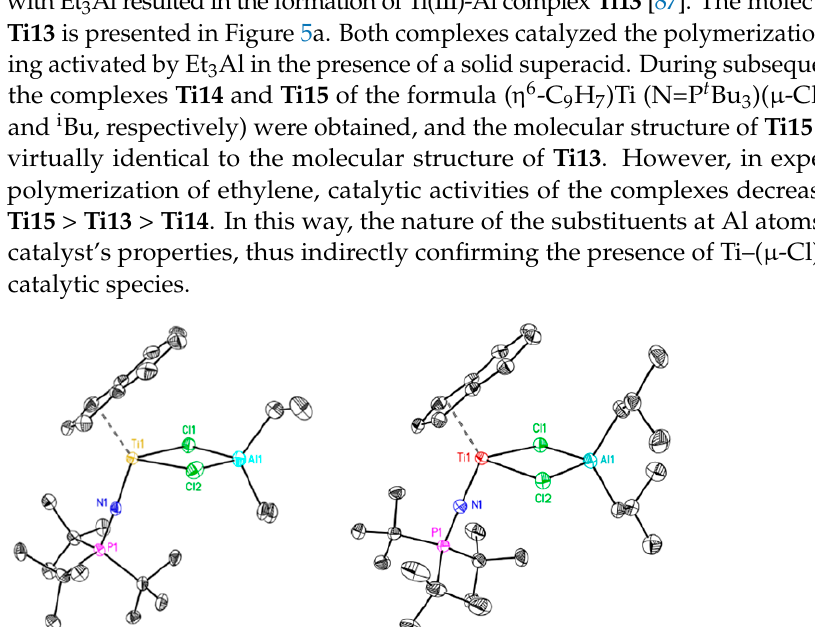
Figure 5. Molecular structure of Ti–Al complexes ( a ) Ti-13 and ( b ) Ti-15 . Reprinted with permis- sion from [88]. Copyright (2021) American Chemical Society. 2.3. Single-Site Ti Catalysts of Polymerization of Dienes